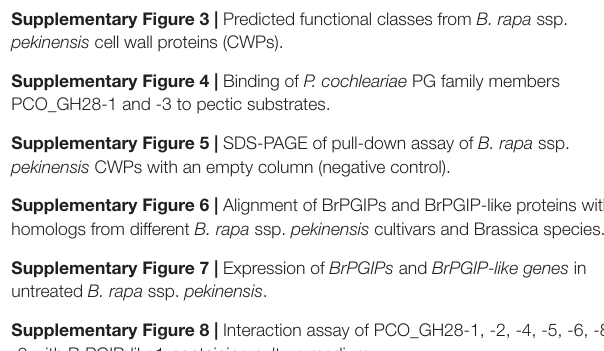
Supplementary Table 1 | List of primers. Supplementary Table 3 | List of protein sequences used for